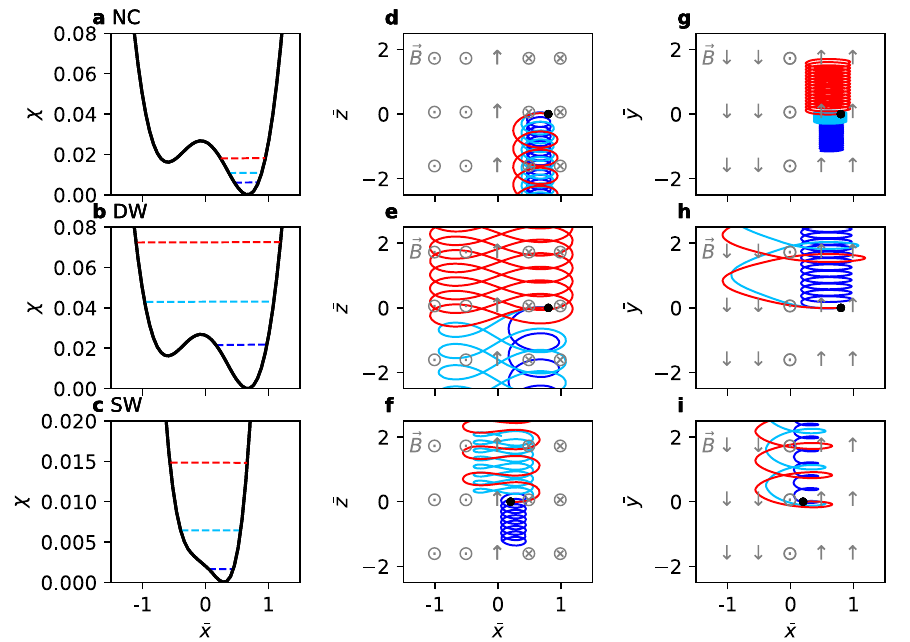
fi eldare represented by dots, crosses, and arrows. The exact magnetic fi eldpro fi le (cid:4) (cid:5) .Threeparticlesareplottedforeachclassandarelabeled is B = B 0 ^ y tanh (cid:2) x +0 : 15 ^ z by the blue, cyan, and red colors. Each particle ’ s energy is represented by its cor- responding color in a – c . g – i Particle orbits in the (cid:2) x (cid:2) (cid:2) y